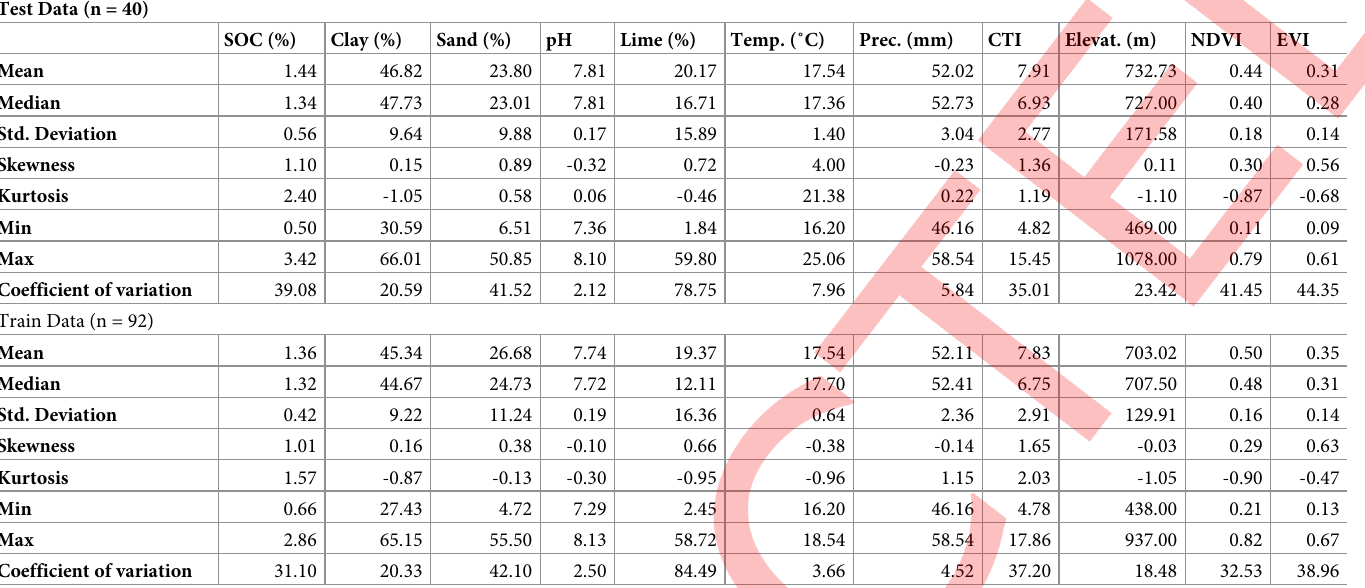
Table 1. Descriptive statistics of soil properties, climate characteristics and vegetation indices at sampling points. Test Data (n =